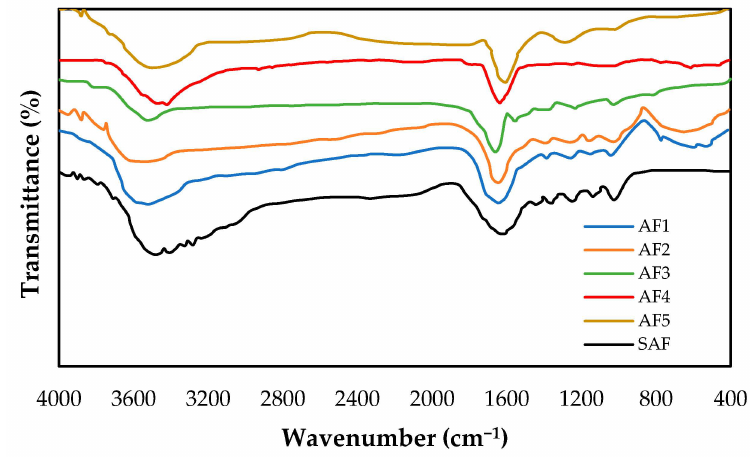
Figure 5. FTIR spectra of AFs. (SAF: standard adhesive formulation; AF1: Thymus bleicherianus ; AF2: Thymus capitates ; AF3: Thymus satureioides ; AF4: Thymus vulgaris ; AF5: Thymus zygis ). Table 3. Mechanical characteristics of the plywoods manufactured using the elaborated